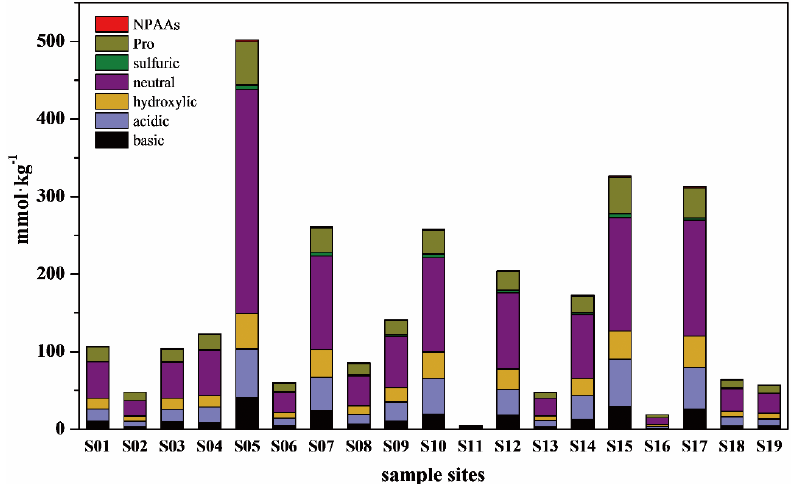
Figure 4. THAAs concentration in surface sediments of Ziya River Watershed.